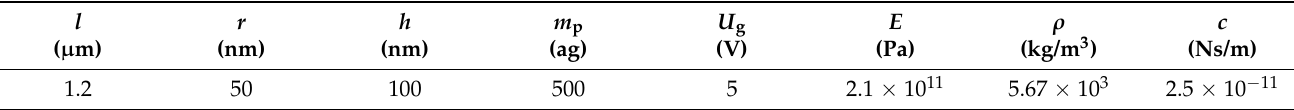
Table 1. Design parameters for the ZnO NW sensor.